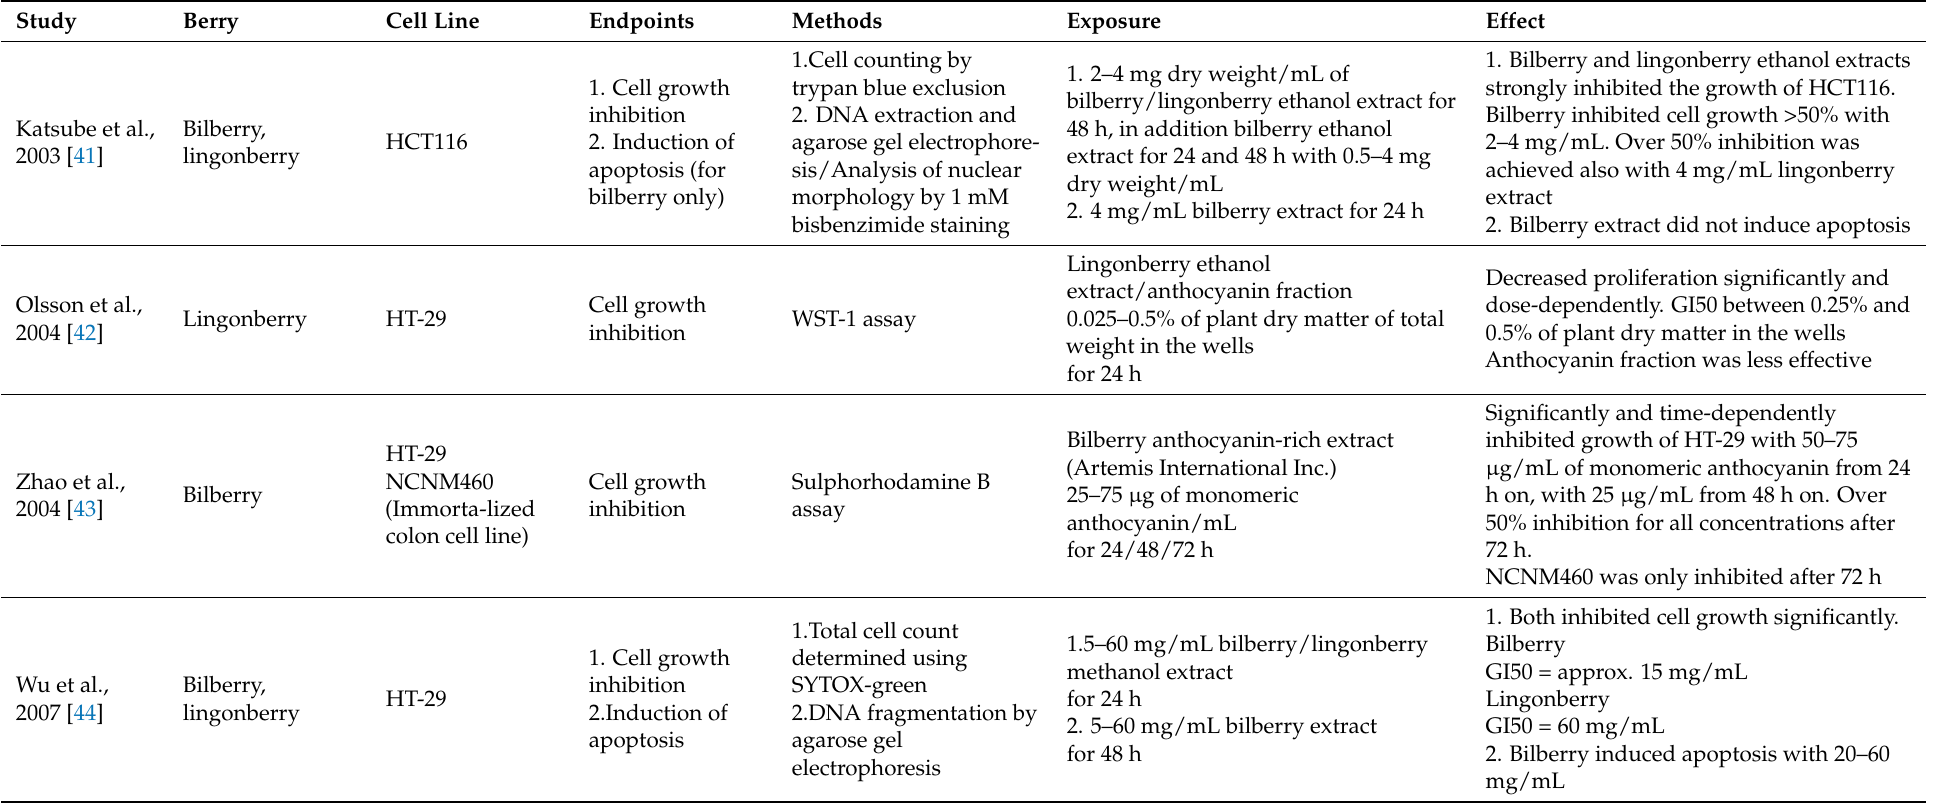
Table 2. Colorectal cancer: Main results of in vitro